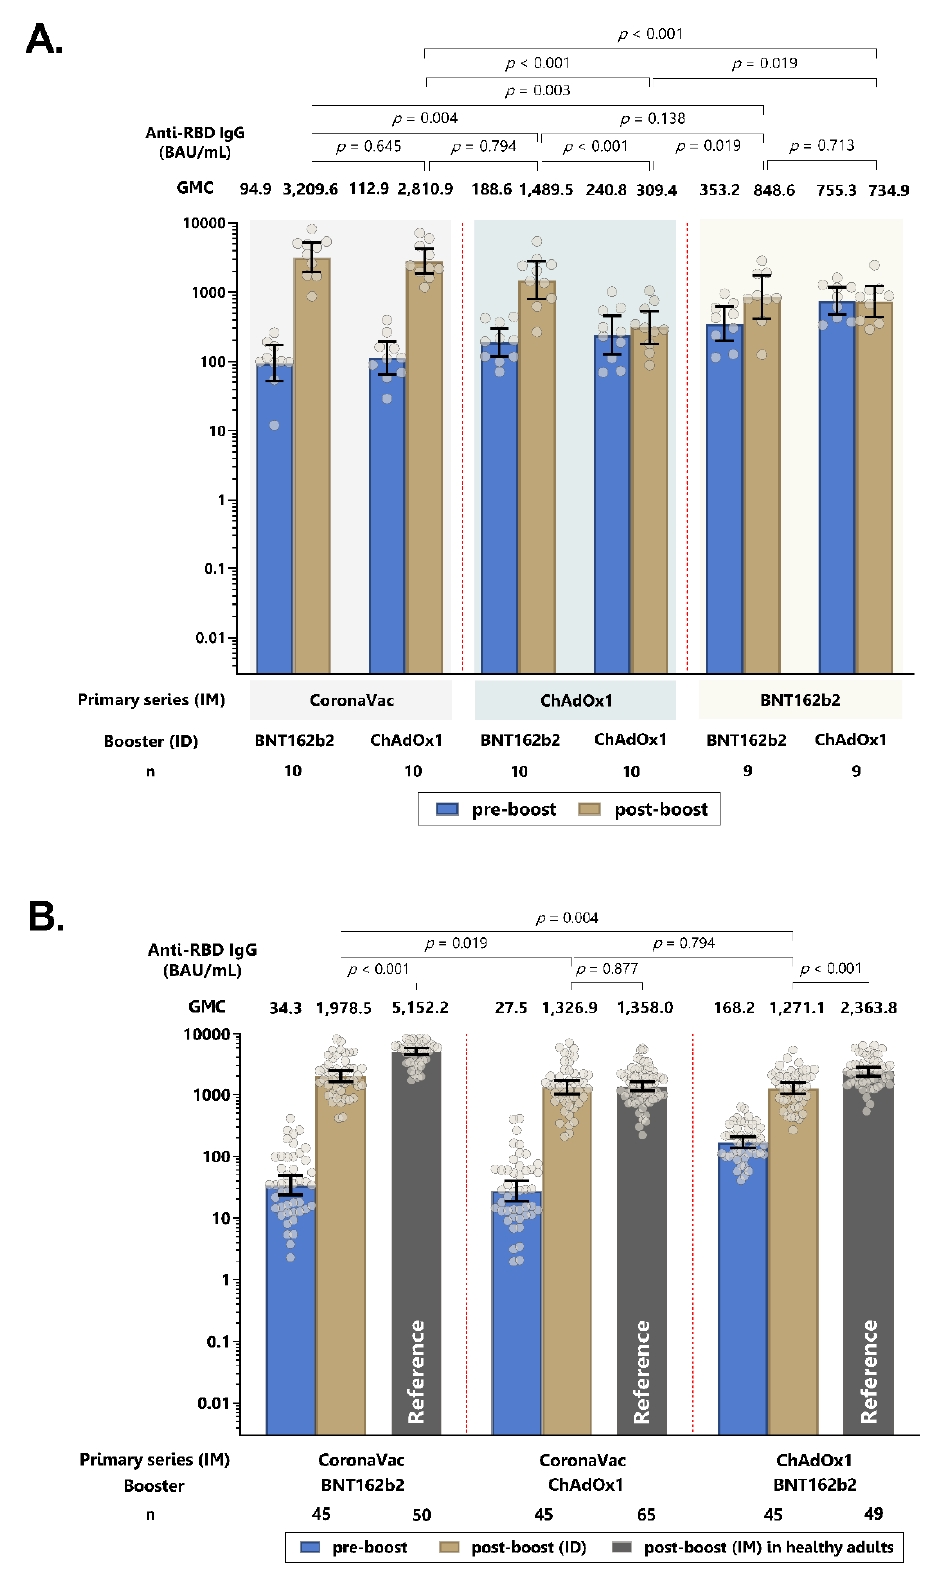
Figure 2. Geometric mean concentration of anti-RBD IgG pre- and post-intradermal (ID) booster dose in the initial phase ( A ) and in initial and extended phase ( B ). Intramuscular (IM) boosting of the same vaccine regimens from the previous study [19] is included as a reference group. Error bars represent geometric mean concentration, plus 95% confidence intervals. BAU: binding antibody units.